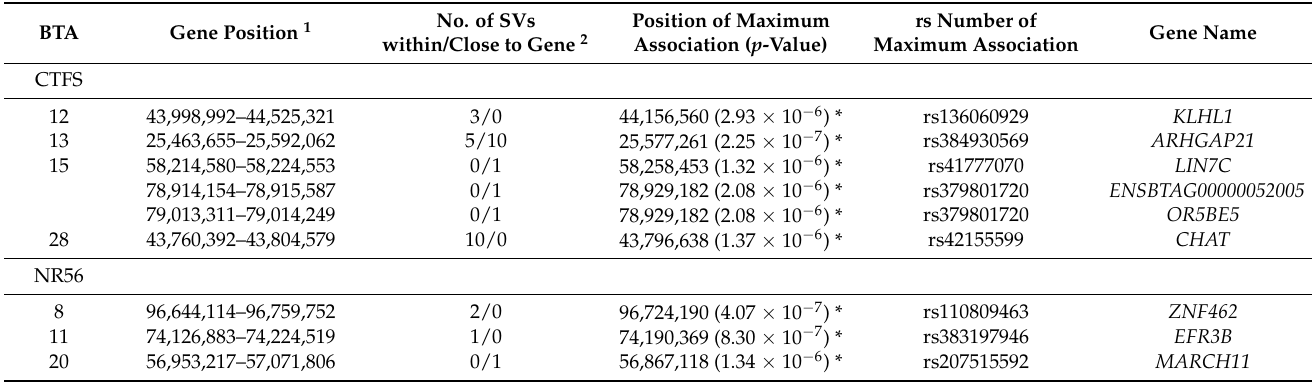
Table 2. Potential candidate genes related to the identified sequence variants (SVs) significantly associated with the female fertility traits calving-to first service interval (CTFS) and non-return 56 (NR56) in DSN. No. of SVs Position of Maximum BTA Gene Position 1 within/Close to Gene 2 Association ( p